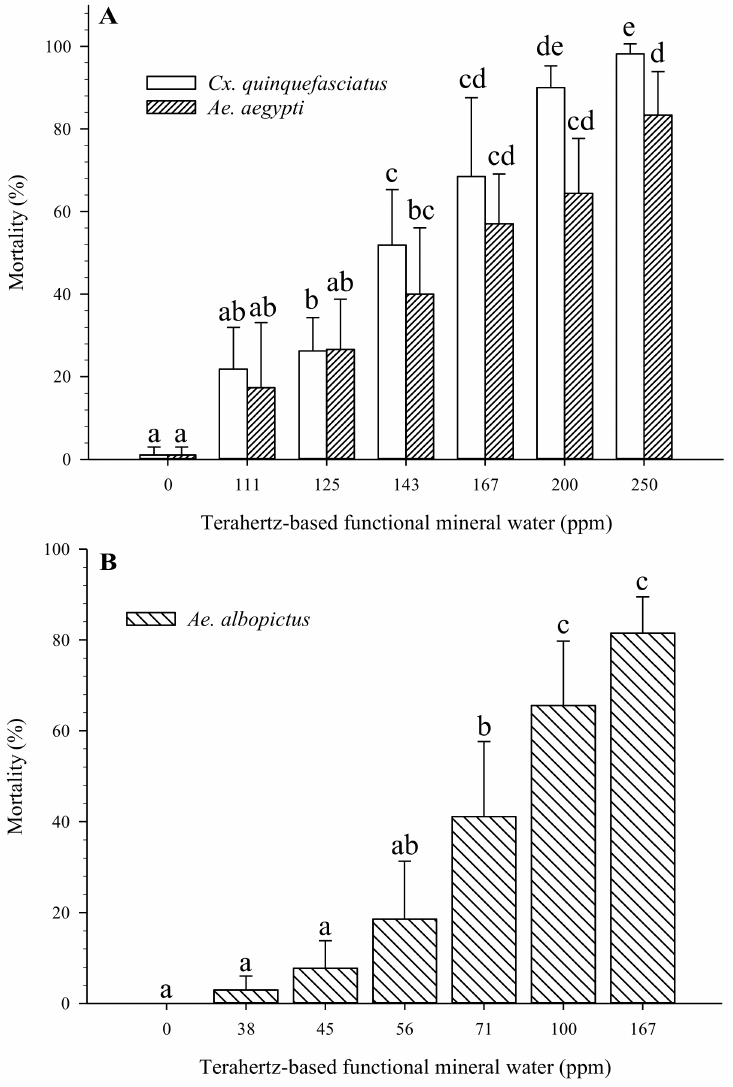
Figure 4. Effects of terahertz-based functional mineral water on mosquito pupae mortality (%). On the second day of pupation, the mosquito pupae were transferred to a solution containing various concentrations of terahertz-based functional mineral water, and pupal mortality rates were recorded after 24 h. Data are presented as mean ± SE values from at least three independent experiments, and different letters indicate significant differences ( p < 0.05) between different concentrations at each species. Table 2. Toxicity of terahertz-based functional mineral water to pupae of vector mosquitoes. Aedes aegypti Aedes albopictus Culex